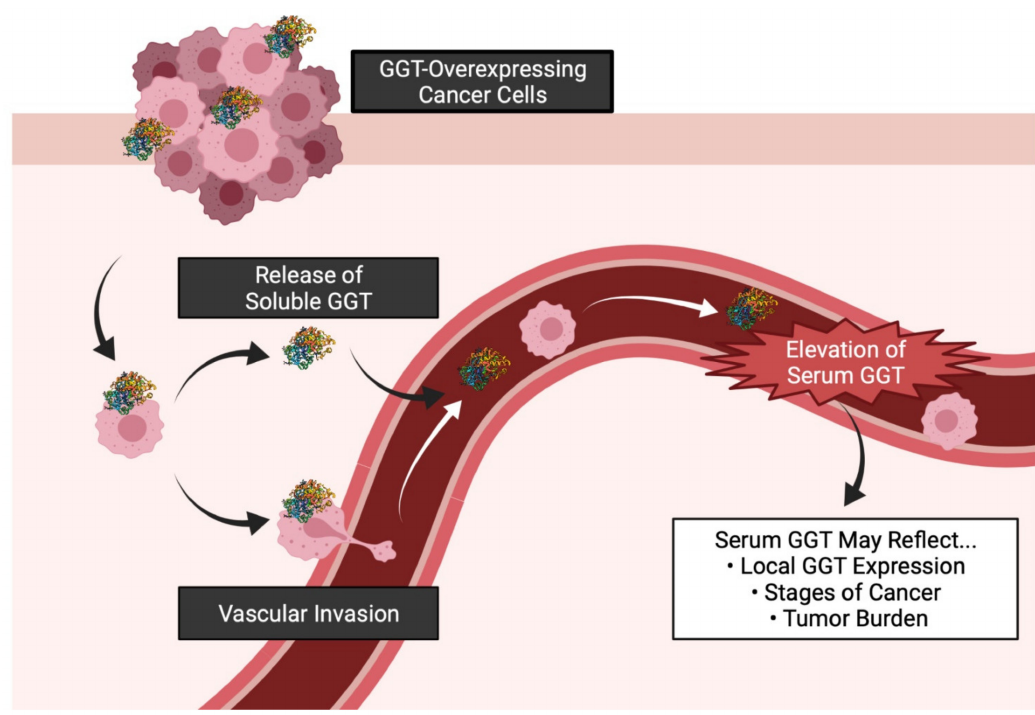
Figure 4. Possible mechanisms underlying serum GGT elevation in patients with GGT-overexpressing cancer cells. Cancer cells may either release GGT or directly invade blood vessels while overexpressing GGT on their cell membrane. GGT can be detected in the peripheral blood of patients especially when cancer cells have high GGT expression, the disease is advanced, or the tumor burden is heavy. GGT, γ